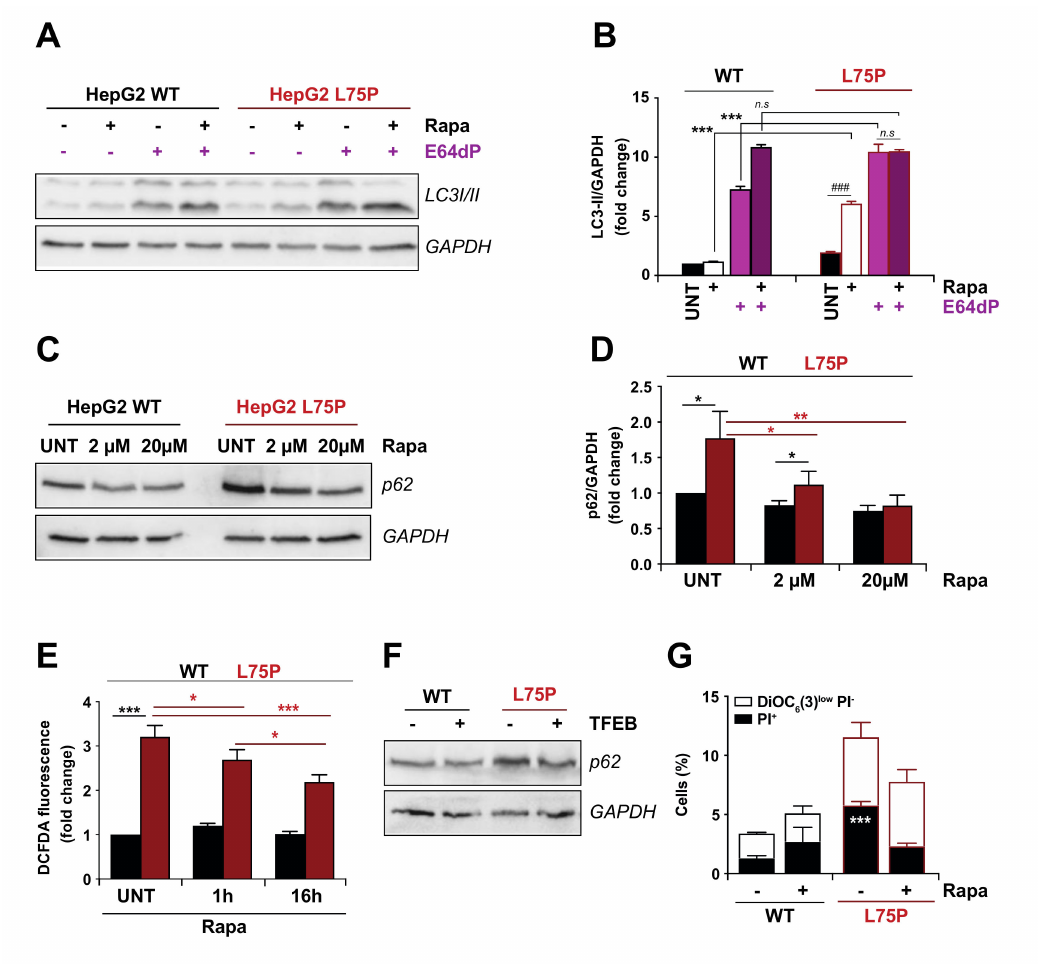
Figure 3. Effect of pharmacological induction of autophagy in L75P-ApoA-I expressing cells. ( A – D ). Autophagic flux evaluation. Wild type (WT) and L75P-ApoA-I (L75P) HepG2 cells were